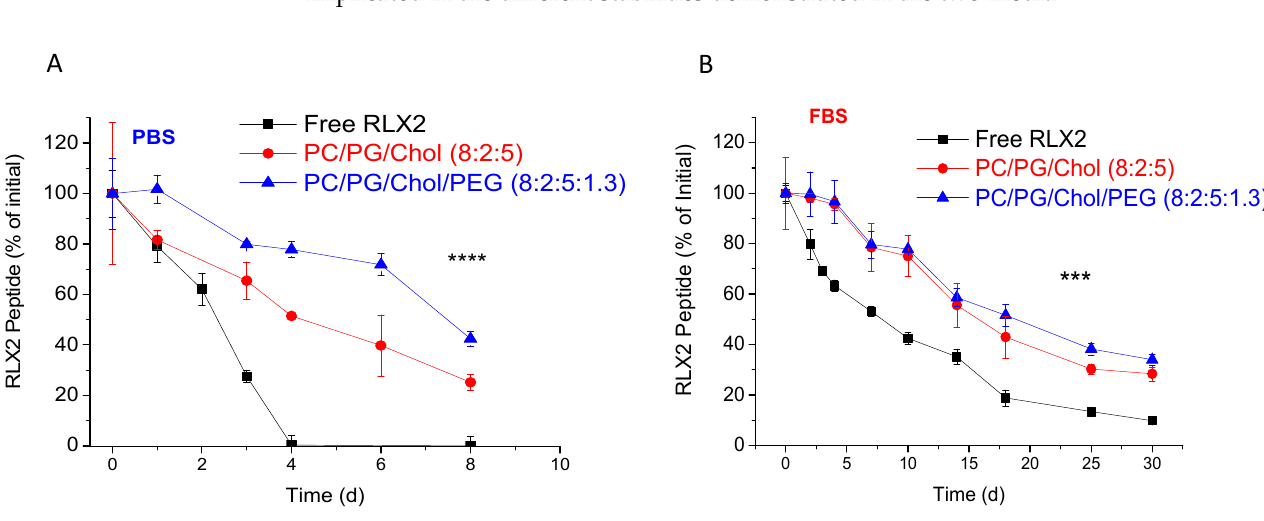
Figure 3. Stability of RLX2 peptide during incubation for 30 d at 37 ◦ C of free or liposomal formula- tions in PBS (pH 7.40) ( A ), or in the presence of FBS (80% v / v ) ( B ). All experiments were conducted at least 3 times, and the reported values are the mean values; bars represent the SD of each mean value. **** p < 0.0001; *** p = 0.0003.